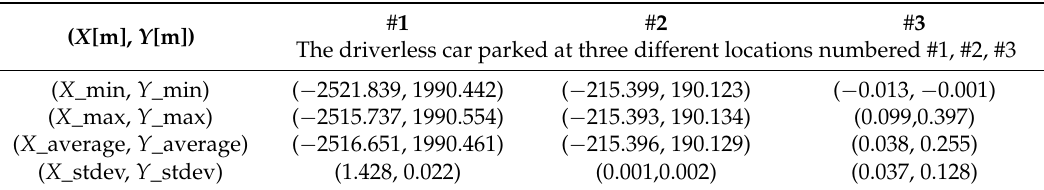
Table 1. Raw records of position data over 10 min.